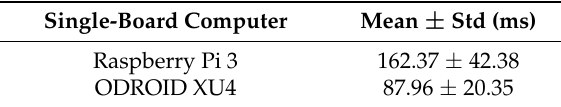
Table 3. Computational performance on embedded computers.